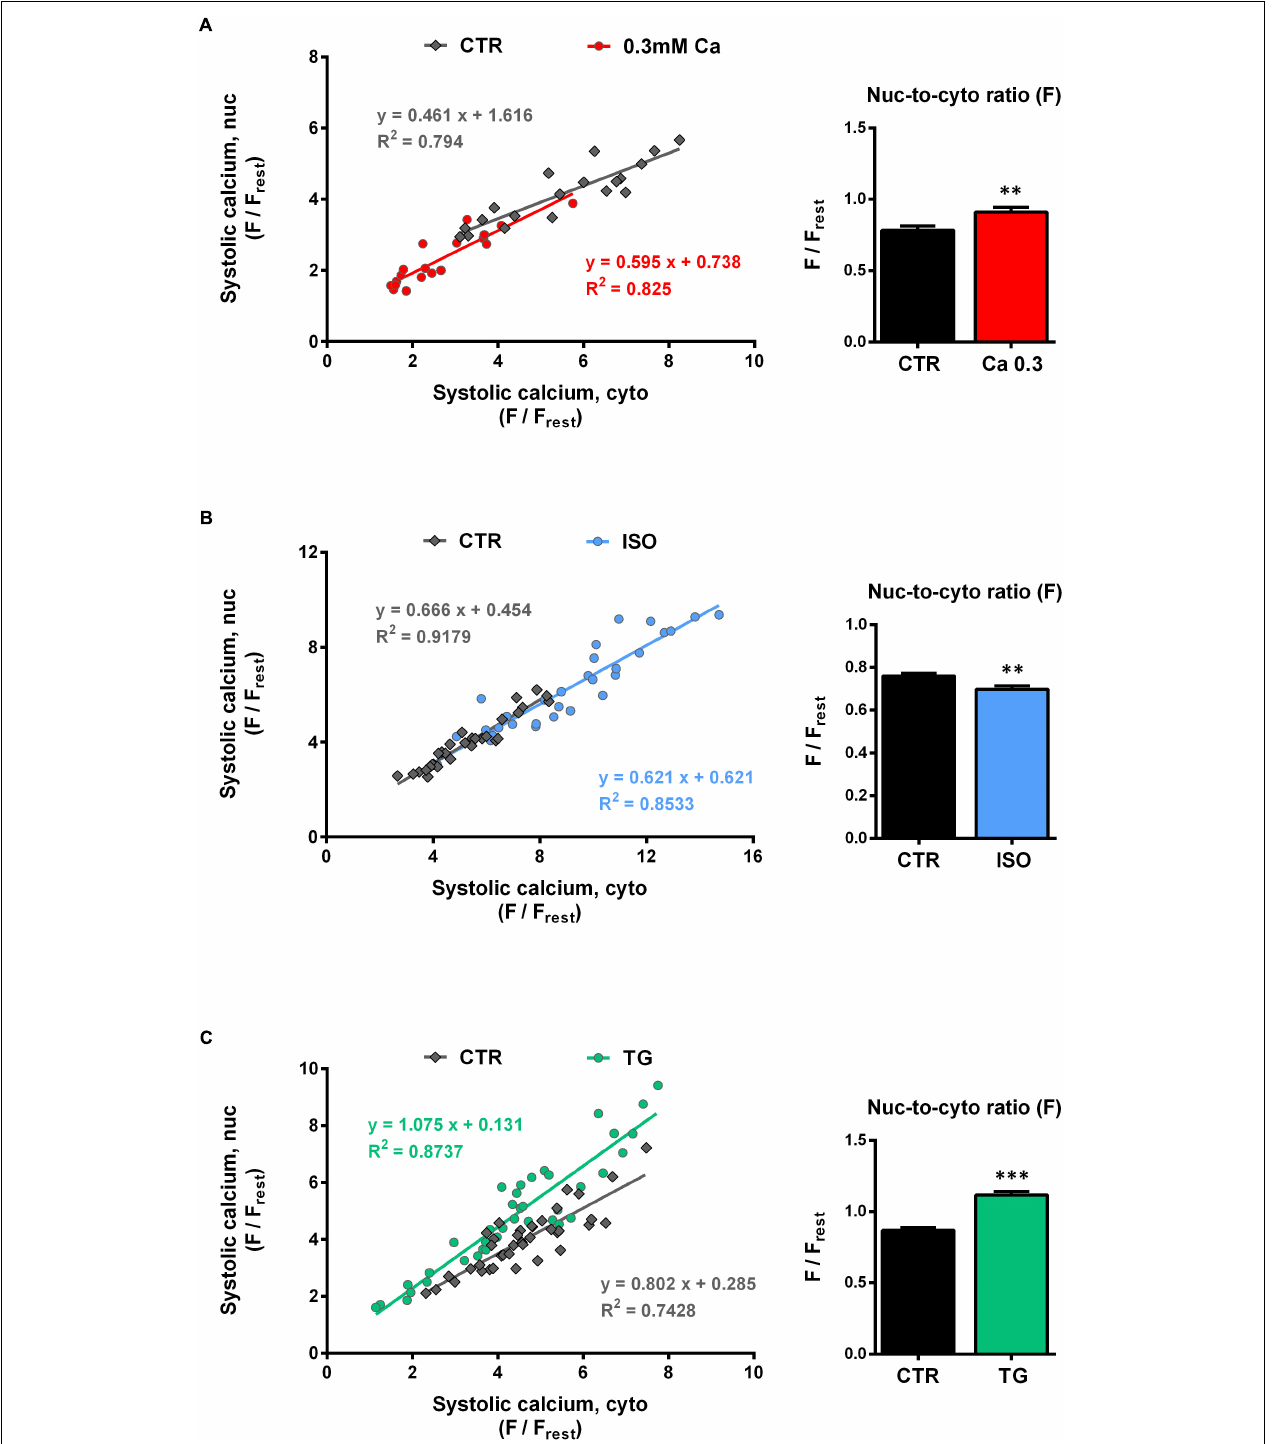
FIGURE 5 | Systolic nucleoplasmic vs cytoplasmic Ca. [ (A–C) , left panels] Nuclear systolic Ca as a function of cytoplasmic systolic Ca. Correlation analysis revealed strong positive correlation for all groups with correlation coefficients r of 0.867 (CTR, 0.3 Ca), 0.874 (0.3 Ca, red), 0.956 (CTR, ISO), 0.931 (ISO, blue), 0.830 (CTR, TG) and 0.913 (TG, green); all P < 0.001. Individual values from the various groups (red = Ca 0.3, blue = ISO, green = TG, black = CTR) were fitted by a linear regression line (as indicated). [ (A–C) , right panel] Average values of nuc-to-cyto ratios (N/C) of the systolic Ca. Significant increases in systolic N/Cs were recorded at 0.3 mM Ca (red) and after TG application (green), whereas exposure to ISO (blue) reduced the N/C significantly. ∗∗ P < 0.01, ∗∗∗ P < 0.001 vs CTR, Ca 0.3: n / N = 19/7, ISO: n / N = 30/7, TG: n / N = 39/13.